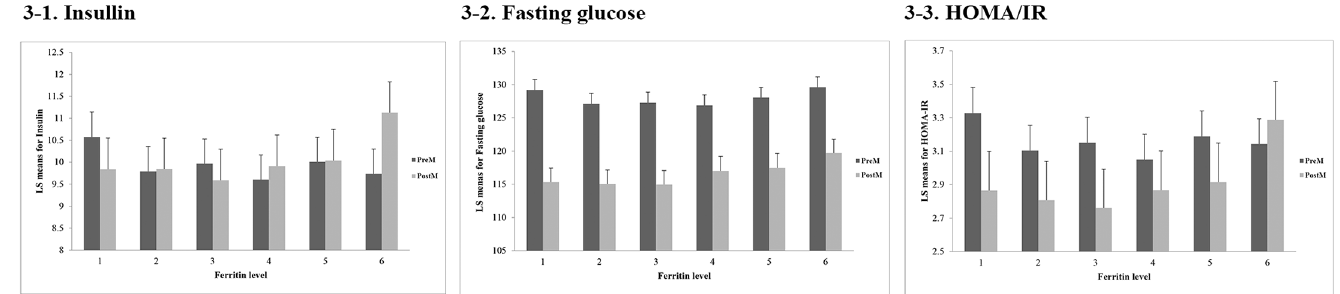
Fig 3. Least square means for insulin resistance indices according to serum ferritin groups after adjusting with